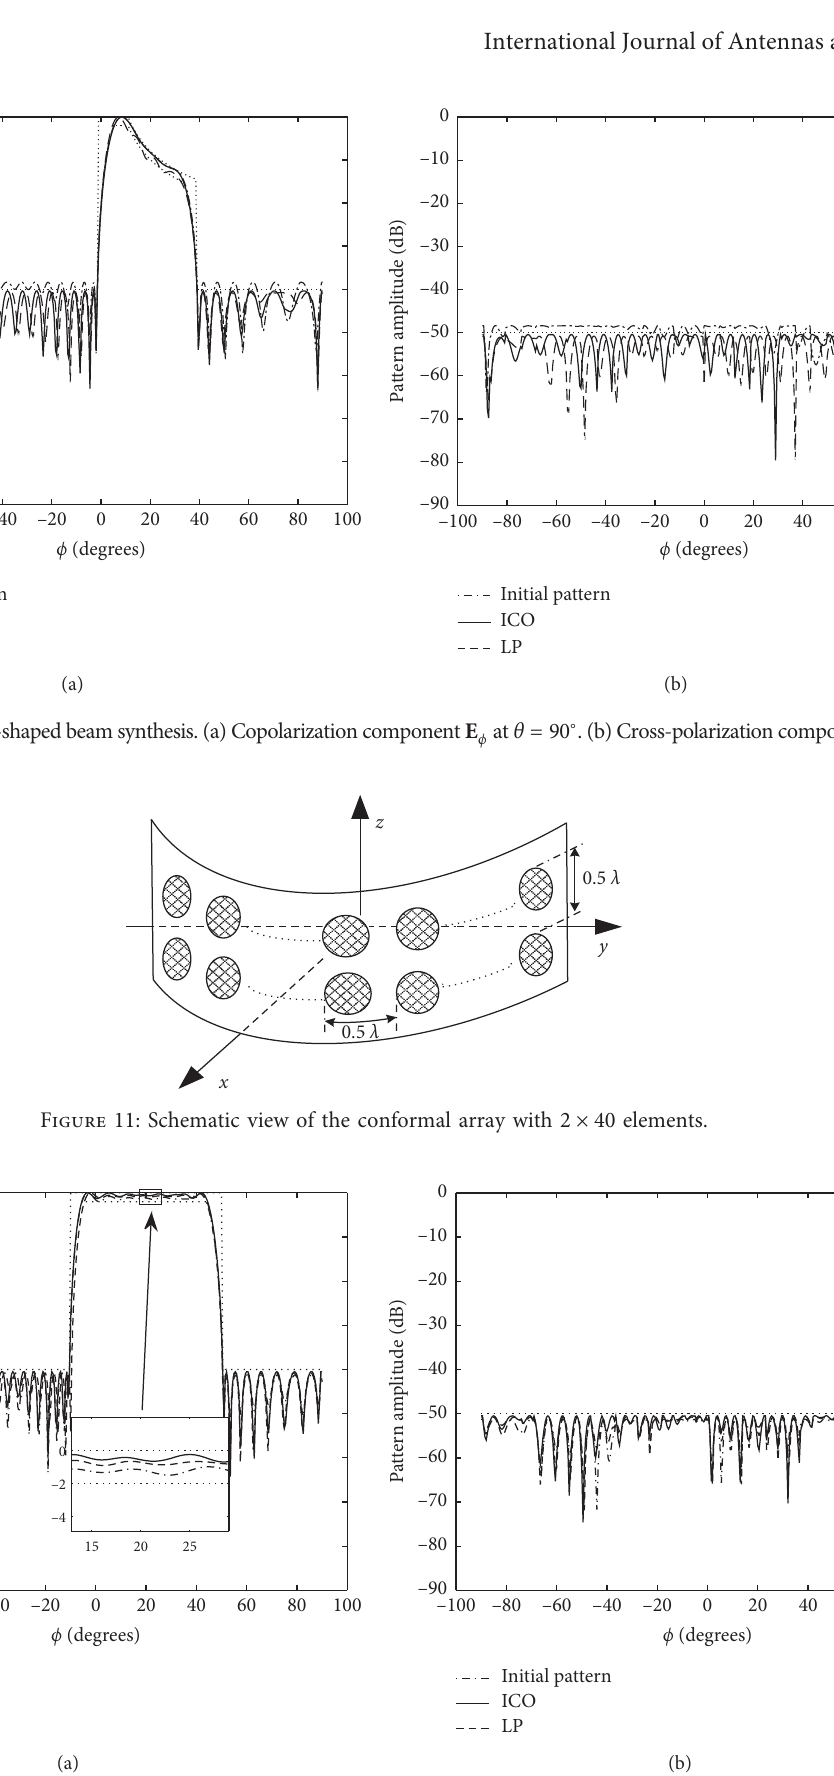
at θ � 90 ∘ . (b) Cross-polarization ϕ